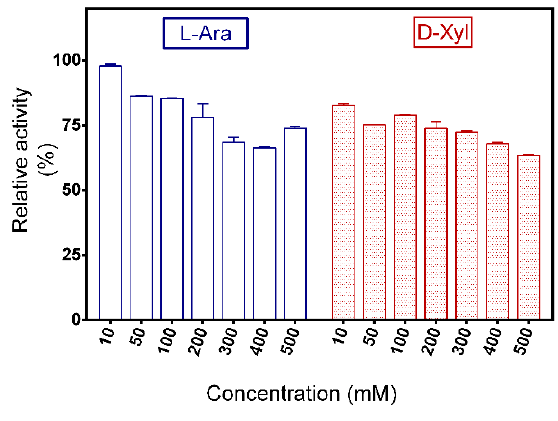
Figure 6. Effect of L-arabinose and D-xylose on the activity of Pp Abf51b. Values represent the mean ± SD ( n = 3).